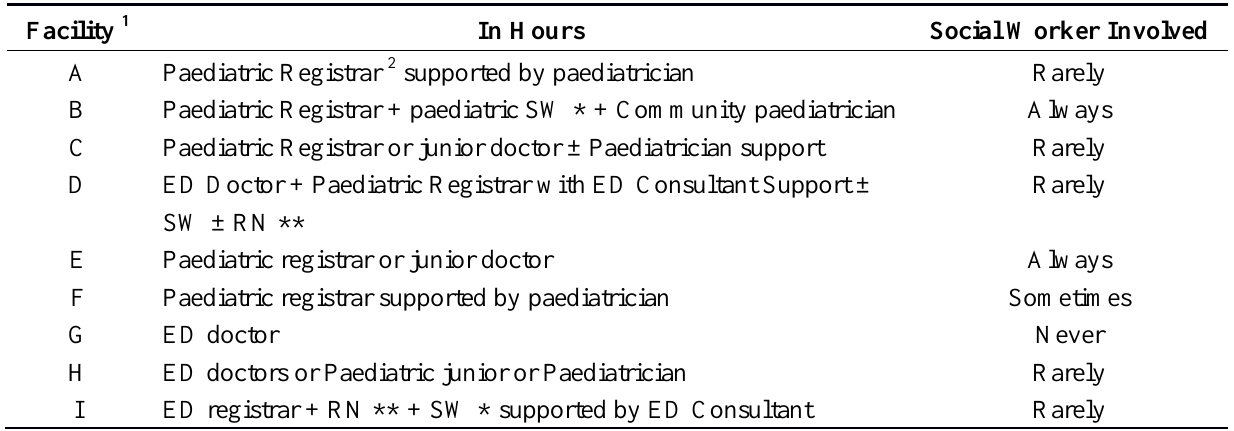
Table 3. Who conducts child physical abuse/neglect assessments?